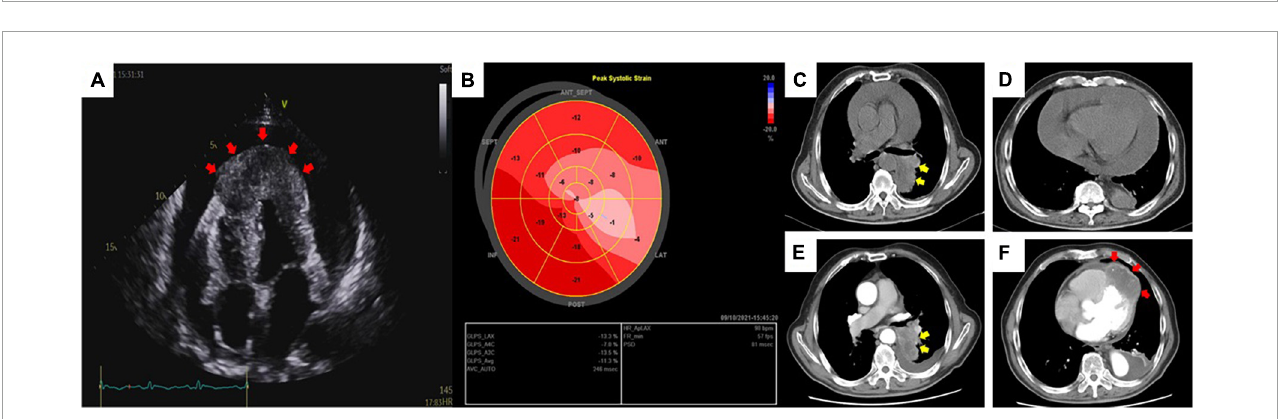
FIGURE2 Transthoracic echocardiography (A) revealed massive pericardial effusion and a thickened and hypoechoic mass (red arrow) at the apex of the heart via an apical four-chamber view. Global longitudinal strain (B) showed a significantly decreased absolute value of strain in the area of the anterior and lateral walls of the heart. Routine chest CT at admission (C,D) and contrast-enhanced chest CT after pericardiocentesis (E,F) showed an irregular iso-density mass (yellow arrow) with peripheral exudation in the left lower lobe of the lung panels (C,E) and a myocardial mass (red arrow) located in the left and right ventricular apex emerging with reduced pericardial effusion panel (F)